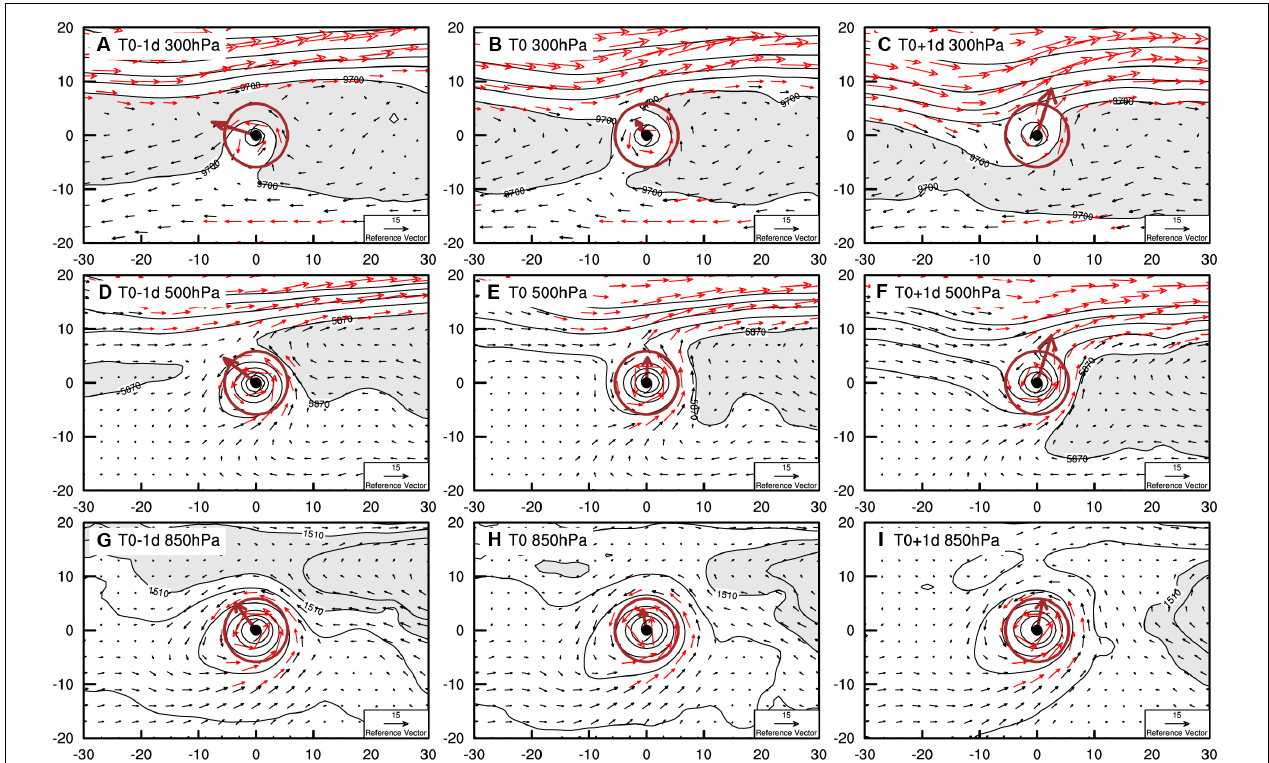
FIGURE 4 | Composite unfiltered winds (vectors, m s − 1 ) and geopotential height (contour, gpm) for the SRT cases (left) 1 day before, (middle) at and (right) 1 day after the turning time. Pressure levels are (A–C) 300 hPa; (D–F) 500 hPa; and (G–I) 850 hPa, respectively. The areas larger than 9700, 5870, and 1510 gpm at respective level are shaded. Red vectors represent wind speeds larger than 8 m s − 1 . The coordinates are the latitudes and longitudes centered on TC center. The brown vector means the composite steering flow averaged in the brown circle.